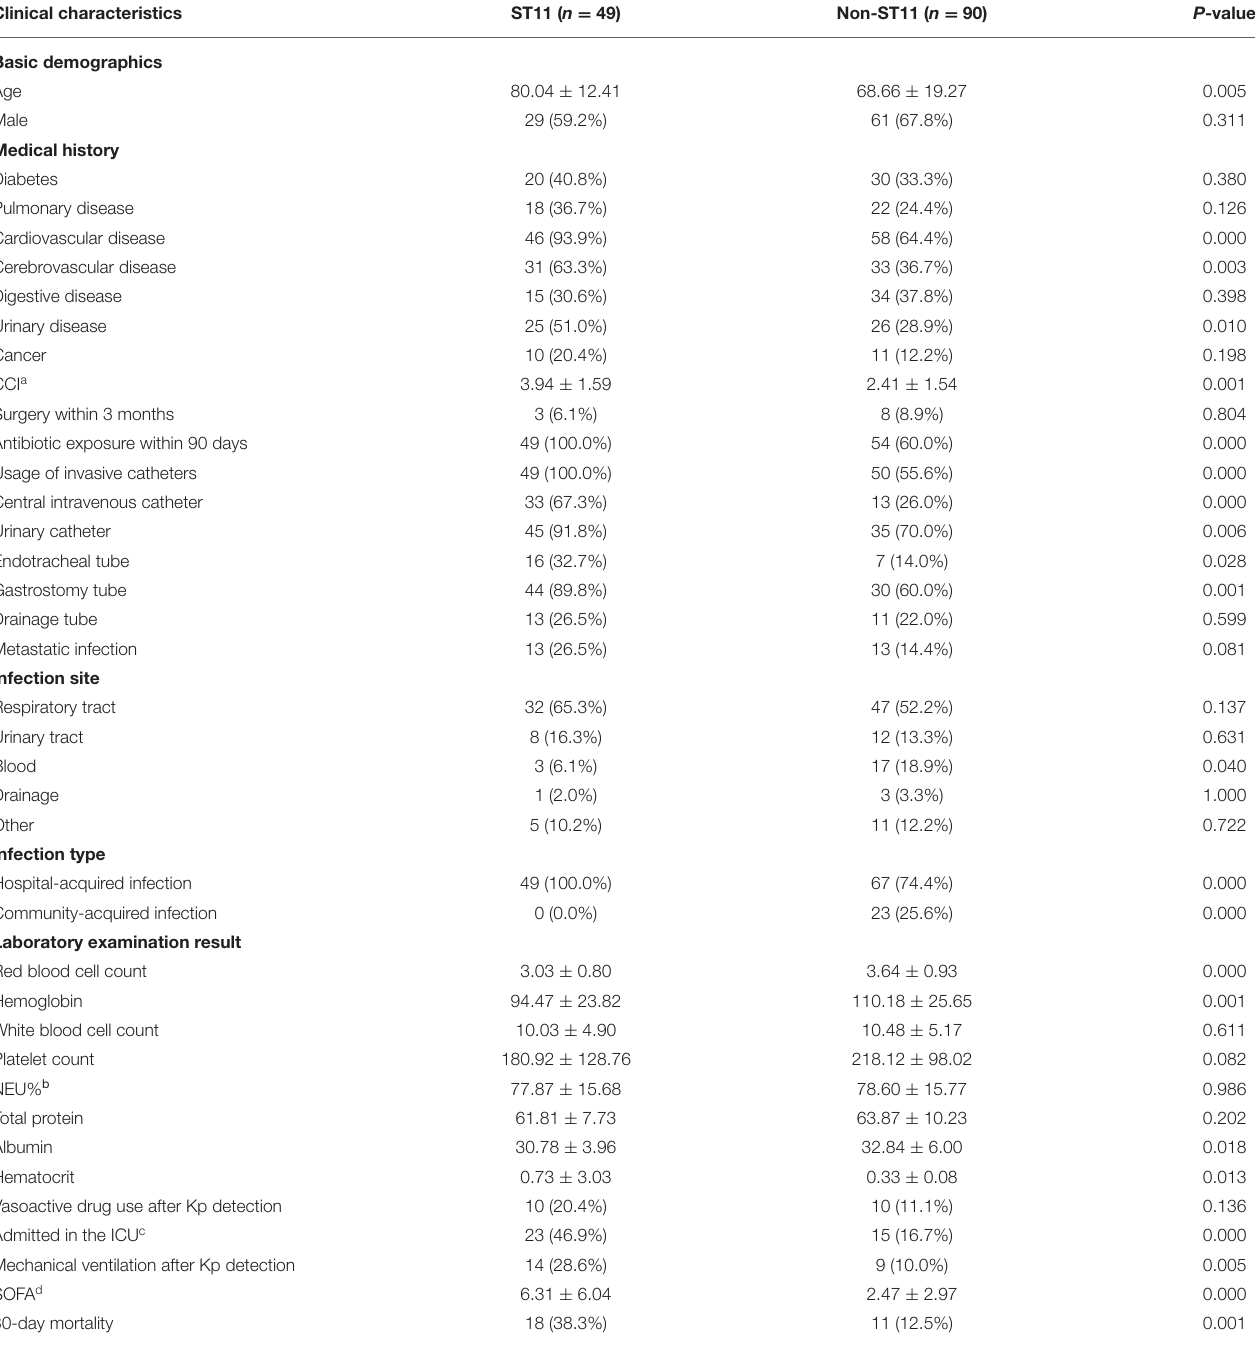
TABLE 1 | Clinical Characteristics of ST11 vs. Non-ST11 Kp. Clinical